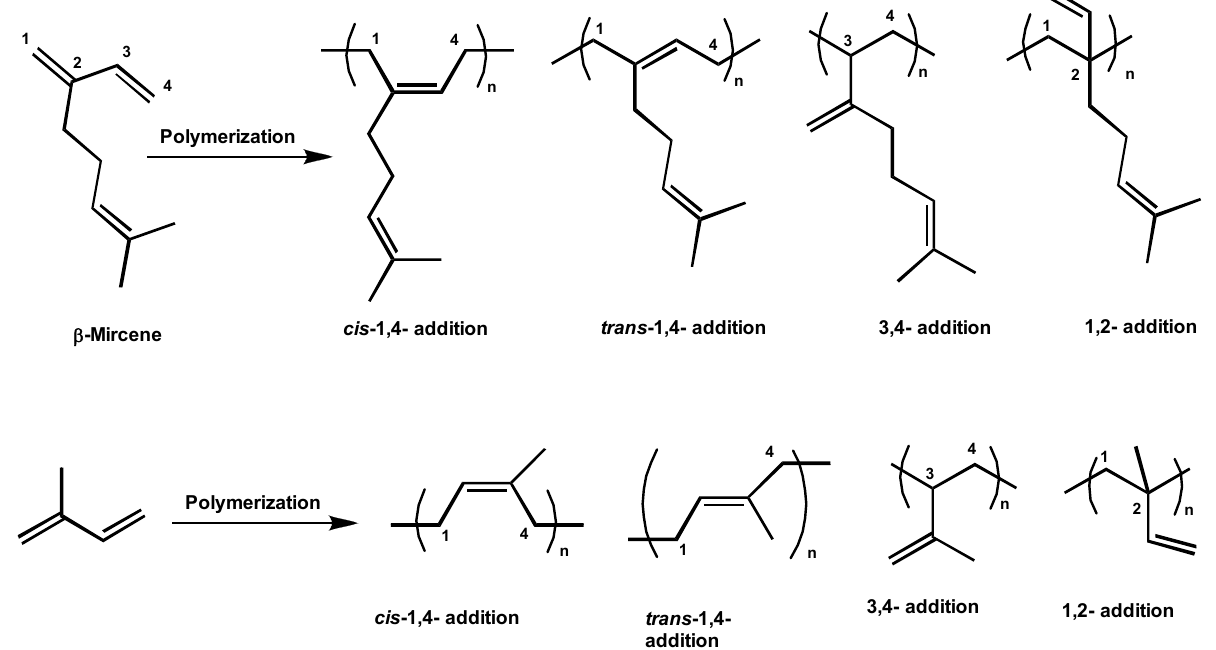
Scheme 1. Possible microstructures depending on the polymerization regioselectivity. Top: poly ‐β‐ myrcene. Bottom: polyisoprene. [70] Reproduced with permission from Mosquera et al., Adv. Organomet. Chem .; published by Elsevier, 2021.